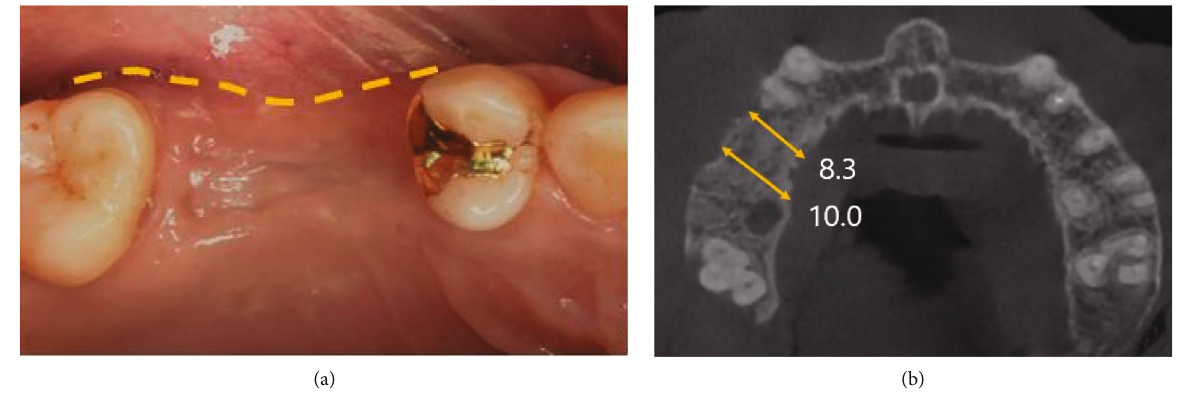
Figure 3: Periodic follow-up at 4 months after operation (Case 1). (a) Intra-oral view. (b) CBCT view. The width of the alveolar bone had